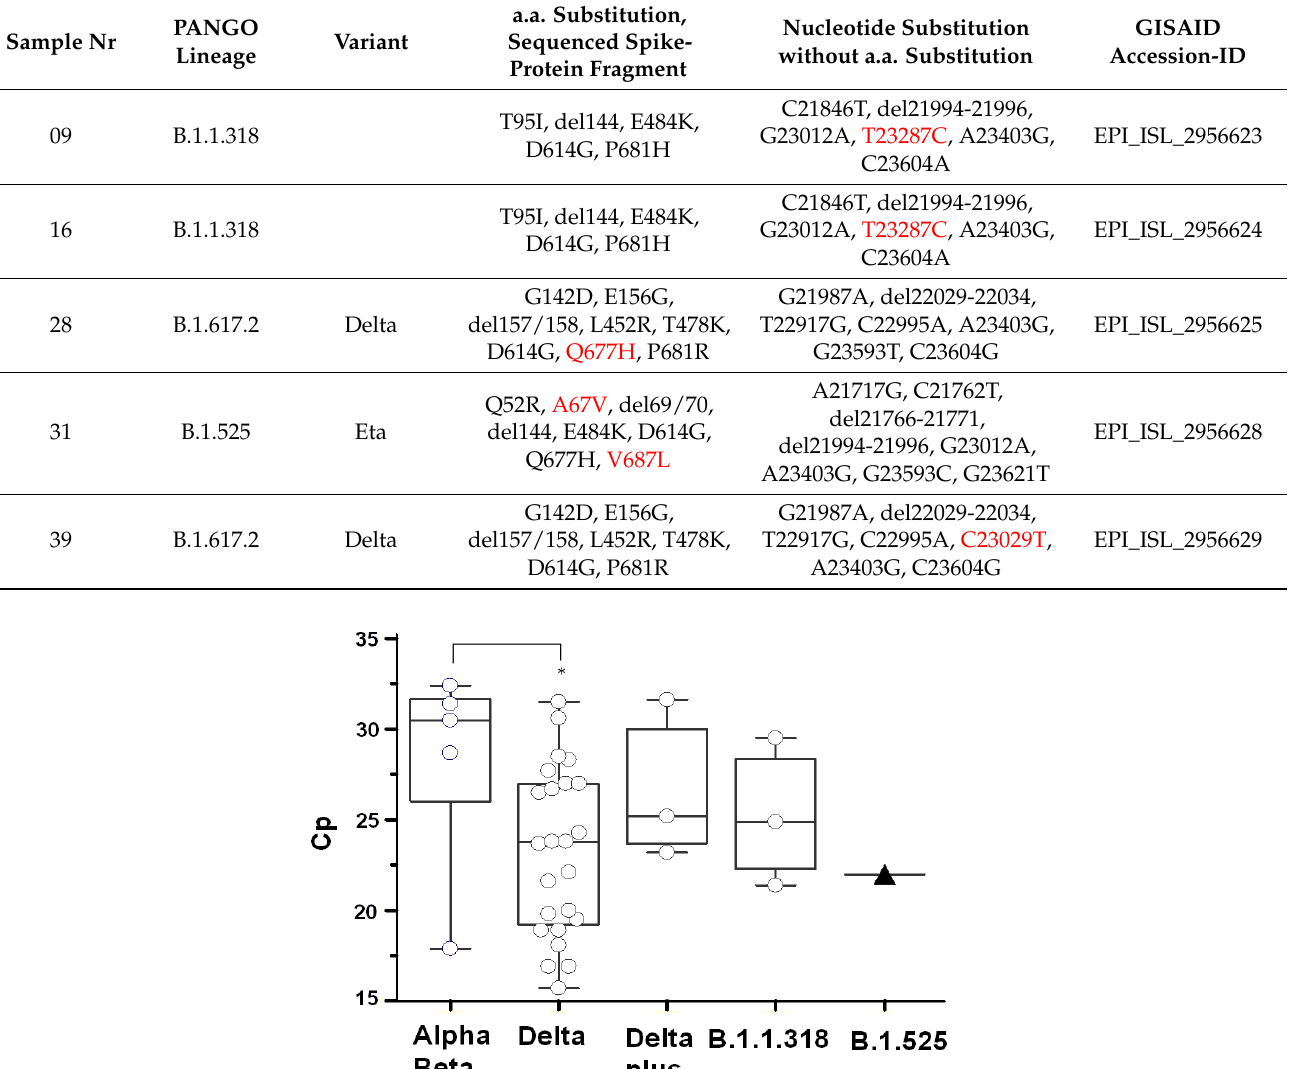
Table 2. Sequence analysis of SARS-CoV-2 lineages and variants. Five mutant sequences were identified and assigned GISAID accession numbers. The rare amino acid (a.a.) mutations in two sequences and the single nucleotide substitutions without a.a. substitutions that affected the melting curve in VirSNiP SARS-CoV-2 typing of the other three sequences are highlighted in red.